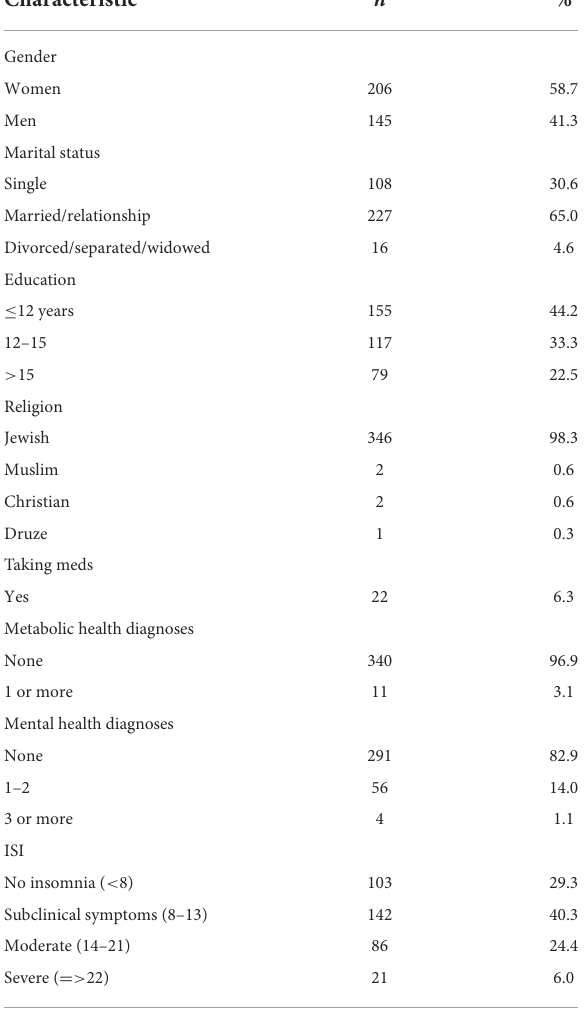
TABLE 1 Sociodemographic